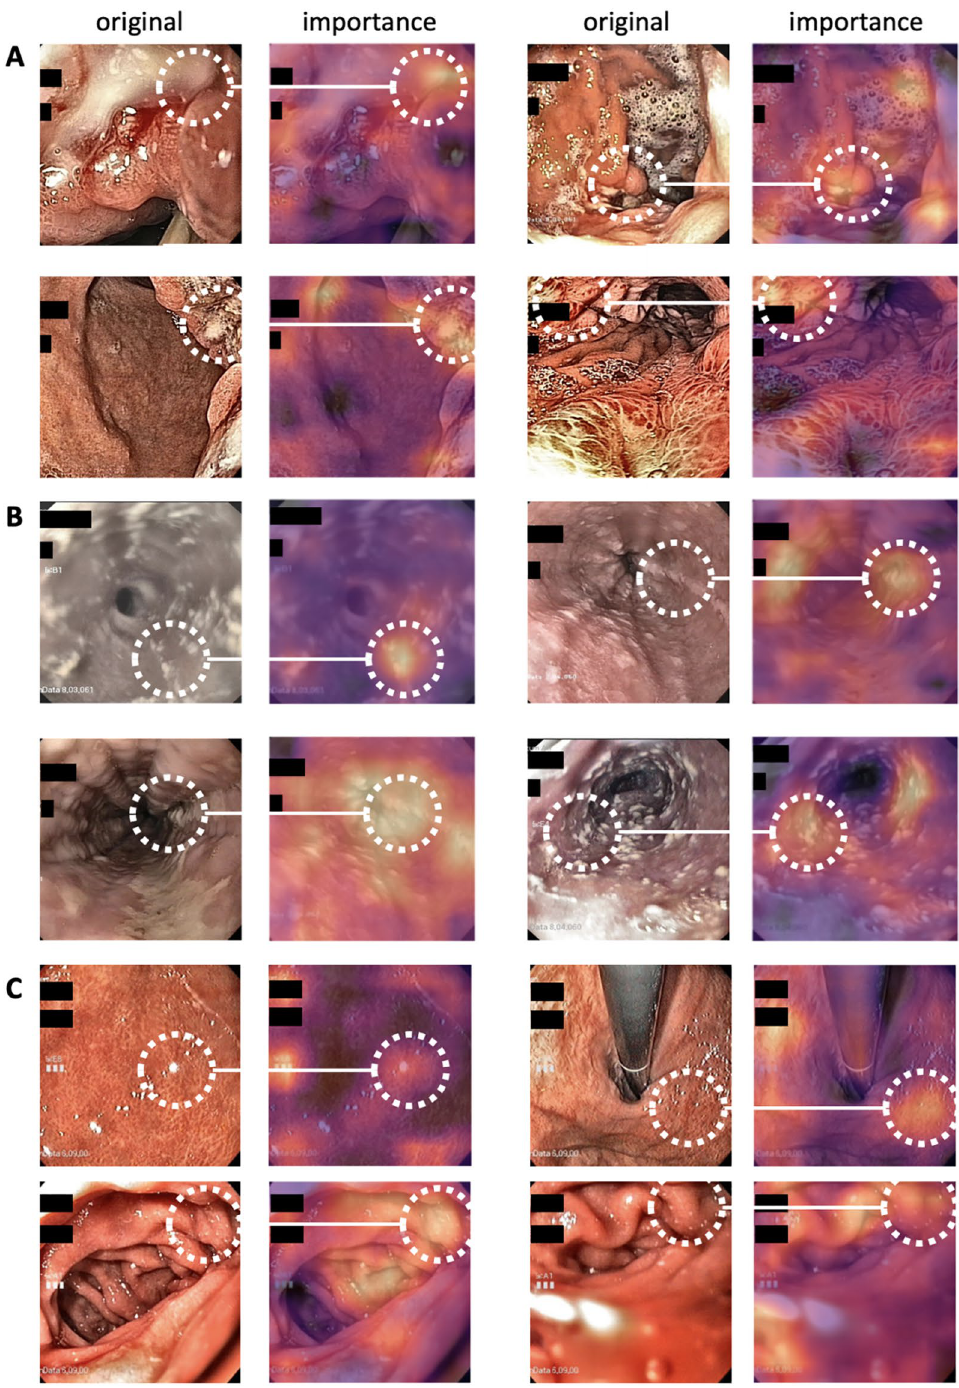
Figure 4. Importance maps for highly predictive image regions in the gastroscopy dataset. ( A ) Representative images with corresponding importance maps (generated by GradCAM) for C16 (gastric cancer). ( B ) Representative images for B37 (candidiasis). ( C ) Representative images for K29 (Gastritis and duodenitis). White circles indicate corresponding areas in the original image and the GradCAM